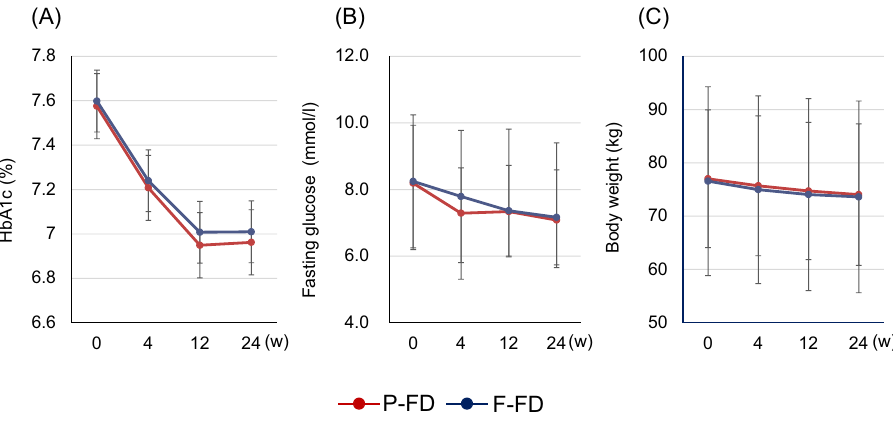
Figure 2. Changes in outcome measures in the group treated with dapagliflozin and protein-rich formula diet (P-FD) and the group treated with dapagliflozin and fat-rich formula diet (F-FD). ( A ) Change in HbA1c, ( B ) change in fasting glucose, ( C ) change in body weight. Data are presented as mean ±